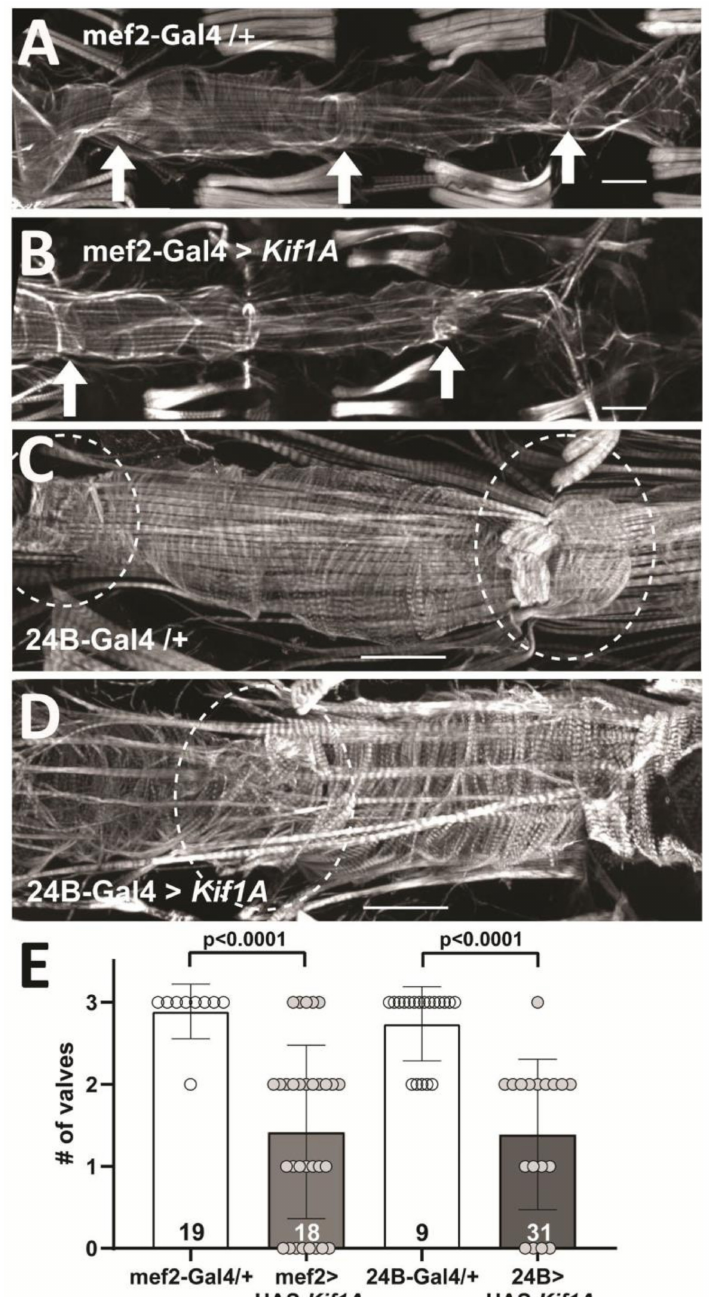
Figure 3. Kif1A overexpression causes valve remodeling: ( A ) F-actin staining with phalloidin of a control heart (mef2-Gal4 /+ ) showing circumferential arrangement of myofibrils in the heart chambers and a denser myofibrillar arrangement in the 3 valve structures (indicated by arrows). Scale bar is 50 microns; anterior is to the left in all pictures. ( B ) In Kif1A overexpressing (OE) hearts (mef2-Gal4 > UAS Kif1A ), the 2 identifiable valves (indicated by arrows) show reduced myofibrillar structure. ( C ) F-actin staining in a control heart (24B-Gal4 /+ ) shows dense myofibrillar structure in the valve (dashed line circle). ( D ) Staining in Kif1A OE hearts (24B-Gal4 > UAS Kif1A OE) shows disorganized and loosely arranged myofibrils in the valve. Note overall reduction in F-actin containing myofibrils in Kif1A OE hearts in both Figure 3B,D. ( E ) Quantitation of identifiable valves in controls (24B-Gal4 /+ and mef2-Gal4 /+ ) and in F-actin stained hearts from Kif1A OE flies (24B > UAS KifAa and mef2 > UAS Kif1A ): The number of hearts is indicated in each bar; **** p < 0.0001, Mann–Whitney